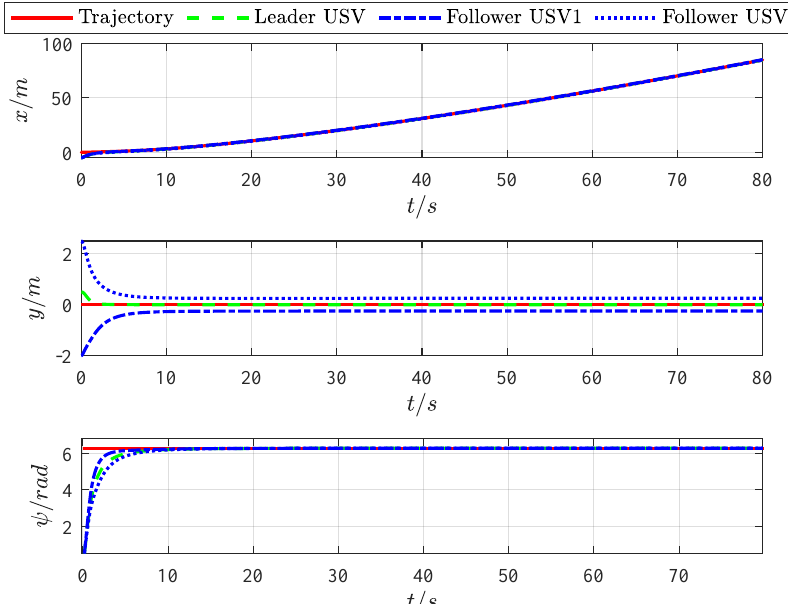
Figure 9. Position tracking of triangular formation of USVs.